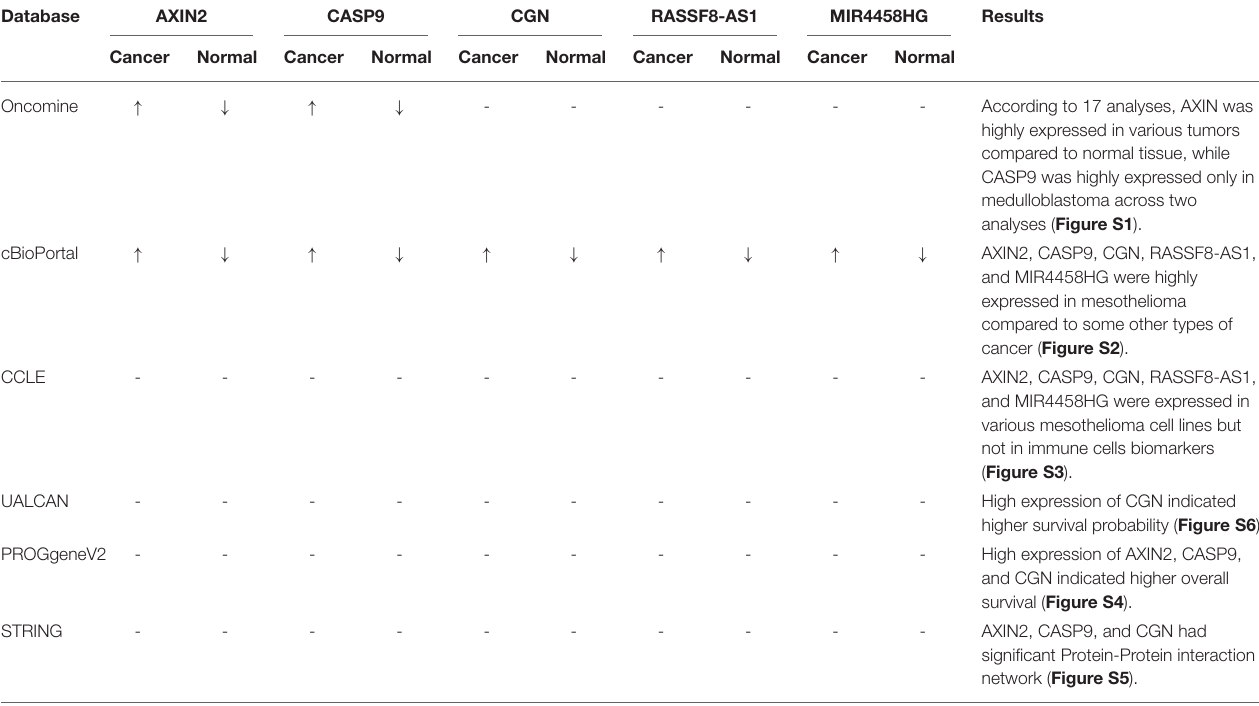
TABLE 2 | Summary of multidimensional external validation results based on multiple databases.